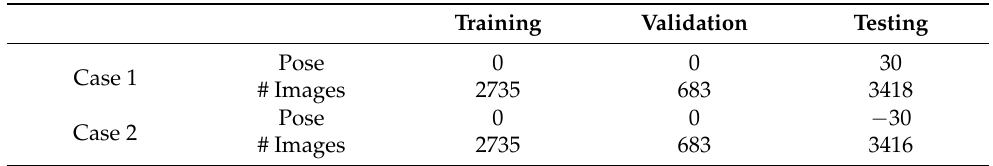
Table 12. Comparison of the results of the LDA-CNN model with other existing methods on cross- pose experiments on UBIPr using the protocol in Table 11.